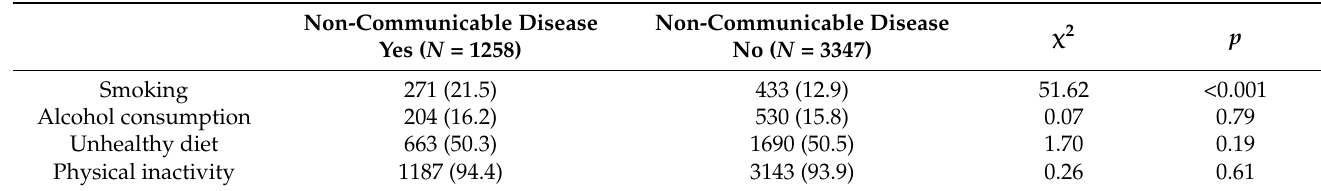
Table 2. Differences in health-risk behaviors between participants with and without non- communicable diseases.